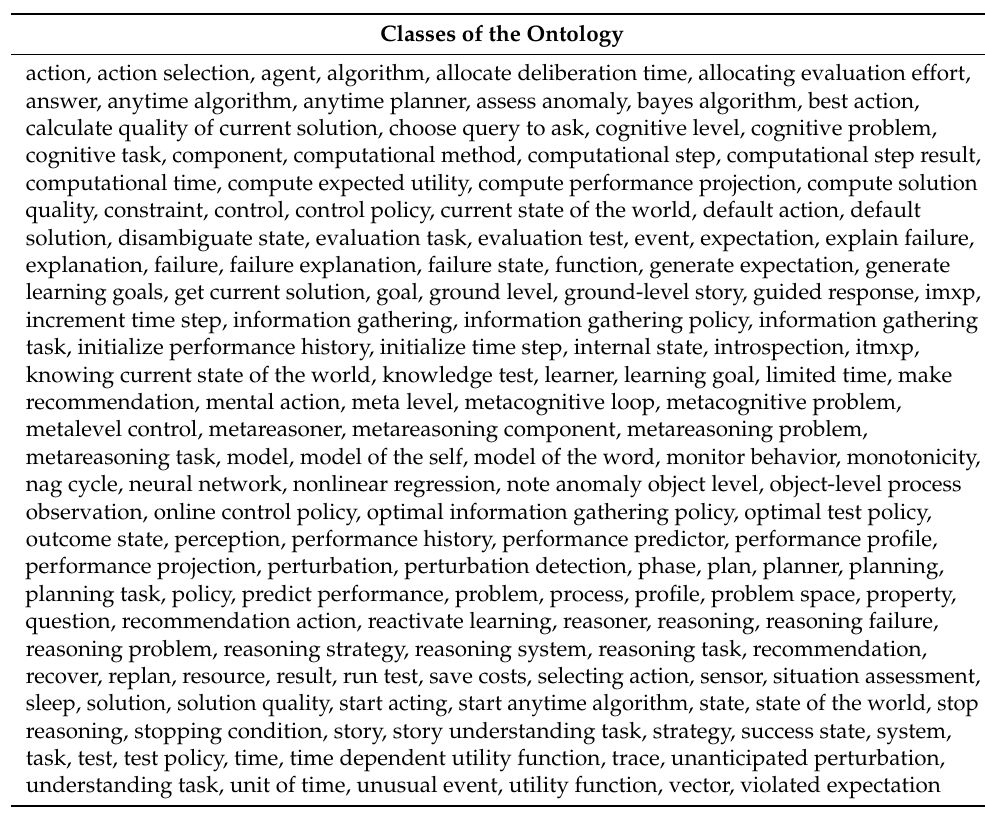
Table 3. List of terms used for class definition in the ontology. Classes of the Ontology